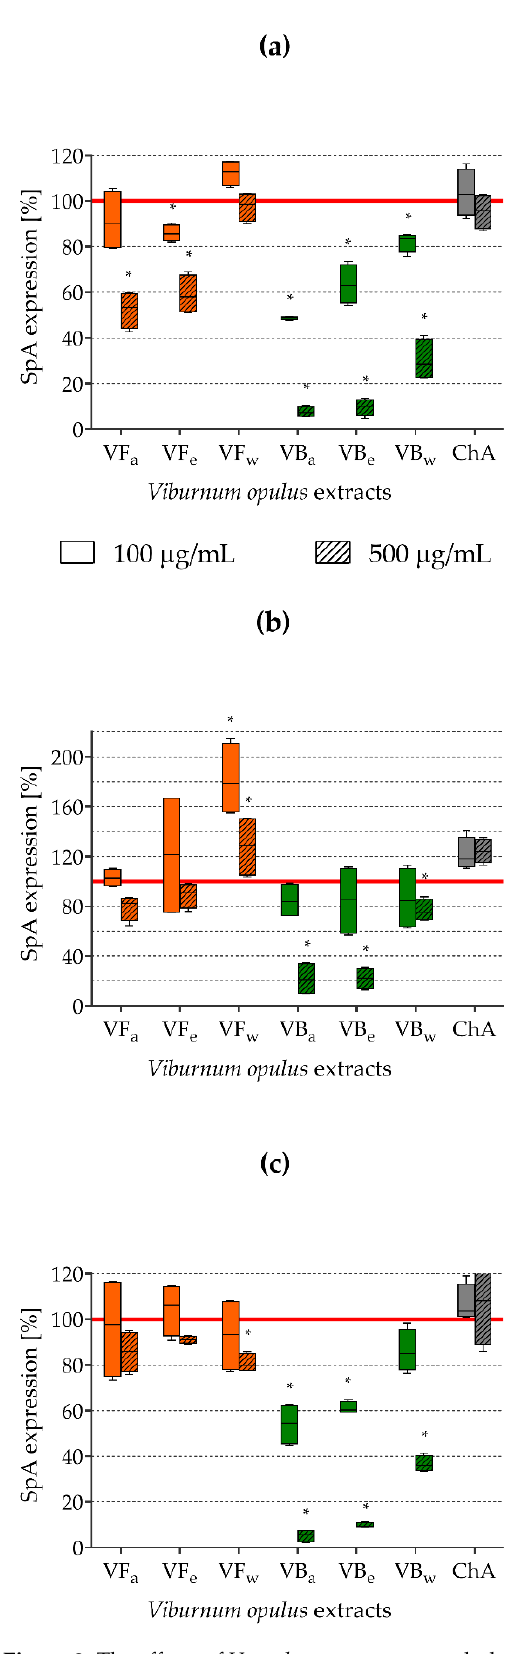
Figure 3. The effects of V. opulus extracts on staphylococcal protein A (SpA) expression on the bacterial cell surface: ( a ) S. aureus ATCC 29213; ( b ) S. aureus ATCC 43300; ( c ) S. aureus H9; VF— V. opulus fruit extract; VB— V. opulus bark extract; a/e/w—acetonic/ethanolic/water extract; ChA—chlorogenic acid; * statistically significant differences compared to the control ( p ≤ 0.05).